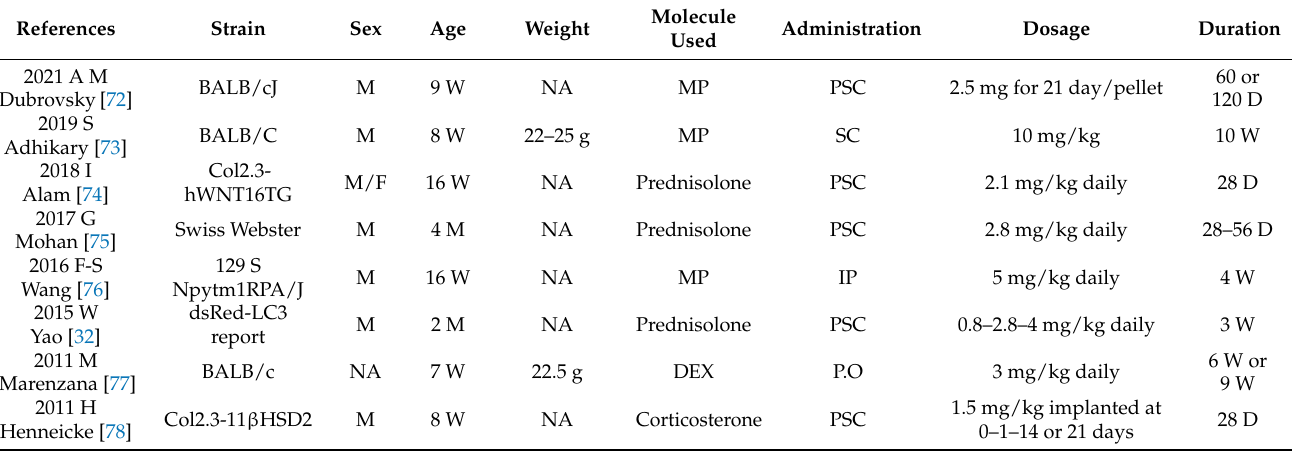
Table 7. Main characteristics of the proposed experimental protocol to induce GIOP in mice (excepted C57BL/6 and their KO derivatives). M = Male, F = Female, DEX = Dexamethasone, MP = Methylprednisolone, P.O = Per. Os, SC = Subcutaneous injection, PSC = Pellet in Subcutaneous, IP = Intraperitoneal injection, NA = Not Available.